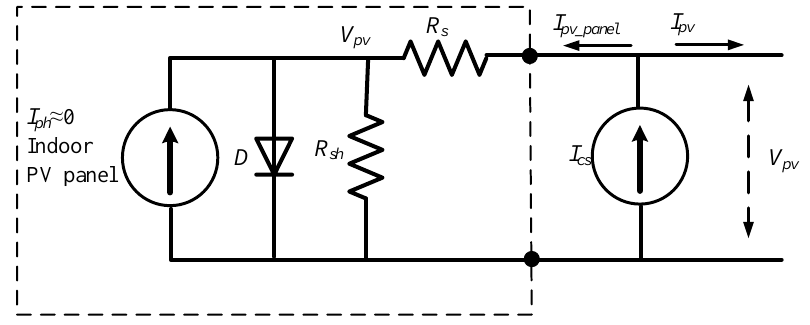
Figure 12. Equivalent circuit of the emulated PV system with a single solar panel.